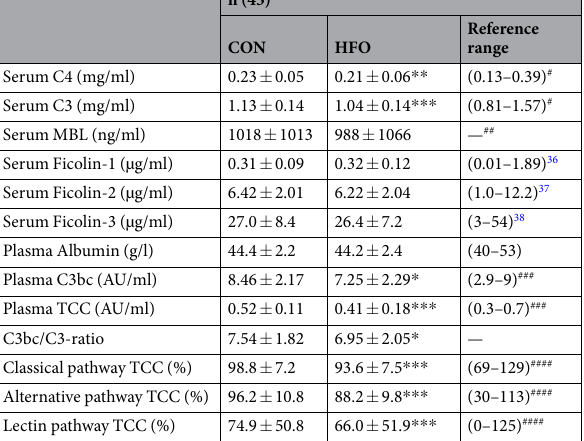
Table 2. Impact of short term high-fat overfeeding on serum levels of C4, C3 and lectin pathway initiators, plasma levels of albumin and complement activation products C3bc and TCC and complement activation capacity in all individuals who completed the overfeeding challenge. Data are means ± SD. AU, arbitrary units; CON, control diet; HFO, High-fat overfeeding; TCC, terminal complement complex. CON vs. HFO